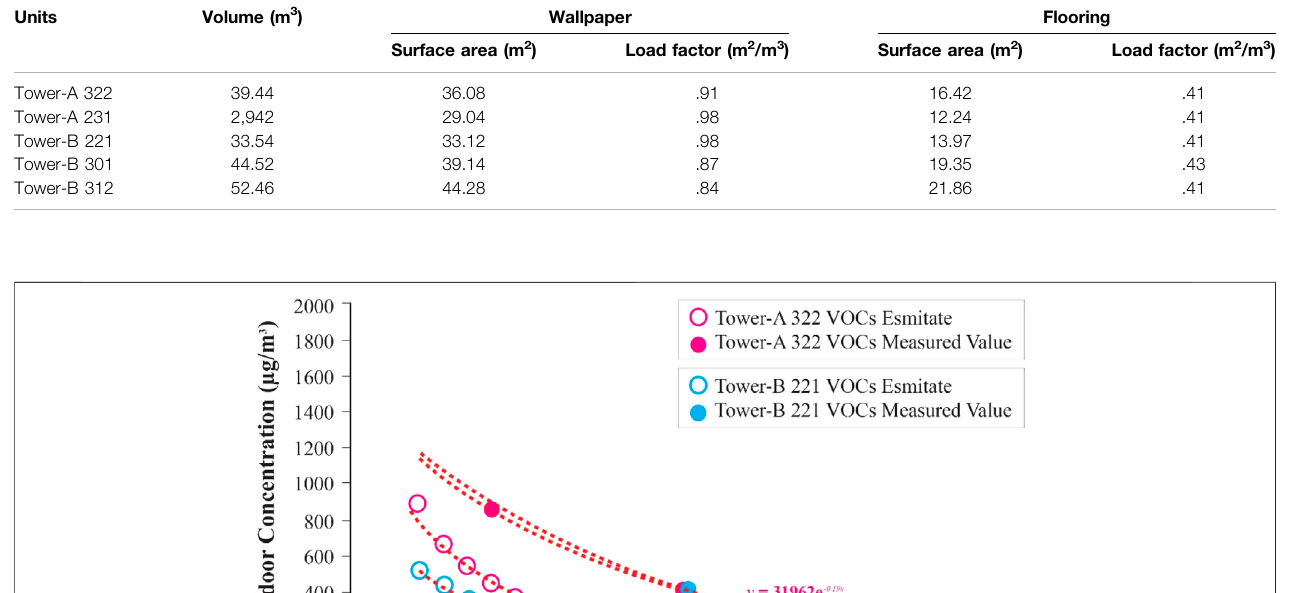
TABLE 9 | Surface area and volume of the living rooms in target units.